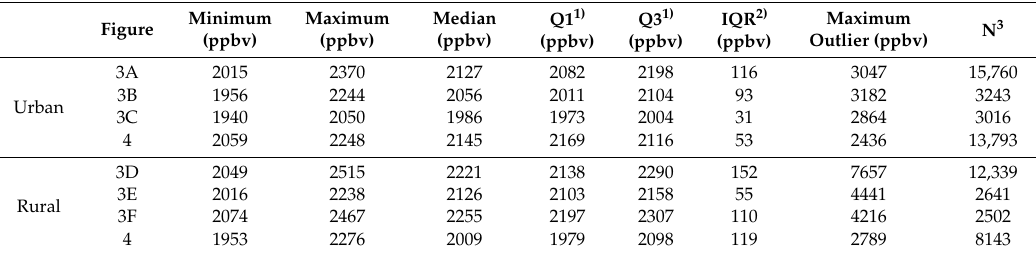
Table 2. Statistics analysis for CH 4 concentration data of the urban and rural